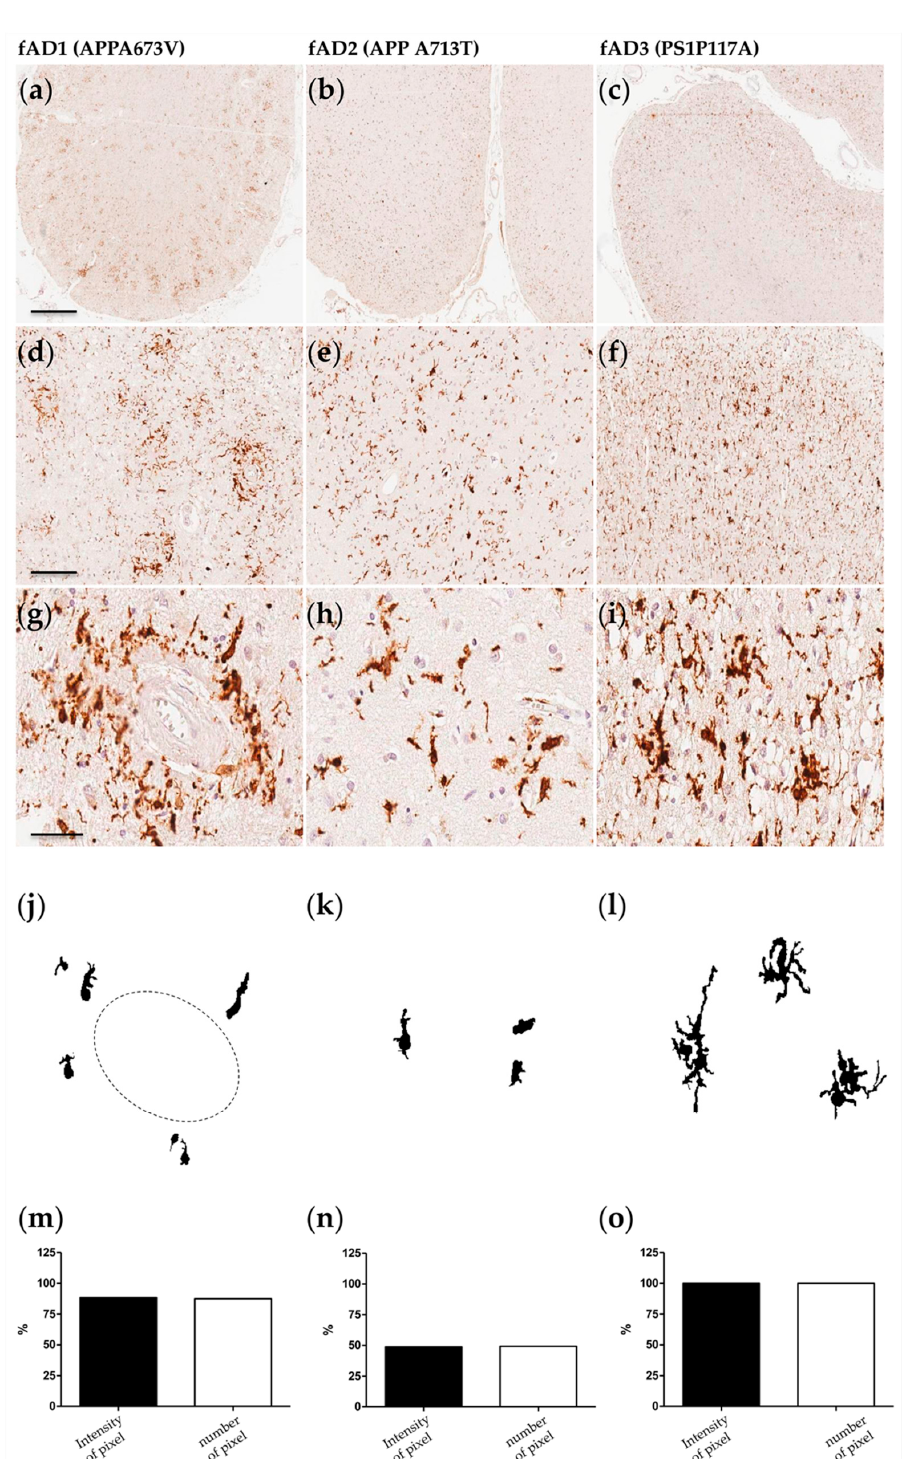
Figure 1. Microglial characterization in fAD cases. ( a , d , g , j , m ) APPA673V (fAD1); ( b , e , h , k , n ) APPA713V (fAD2); ( c , f , i , l , o ) PS1P117A (fAD3). Scale bar 1 mm ( a – c ) 200 μ m ( d – f ); 50 μ m ( g – i ). ( a – i ) Frontal cortex sections immunostained with the IBA1 antibody. ( j – l ) Morphological shape extracted and edited by imageJ software analysis. ( m – o ) Quantification of IBA1 immunoreactivity based on the intensity and number of pixels (data were normalized respect to the higher signal obtained among Alzheimer’s Disease (AD) samples).